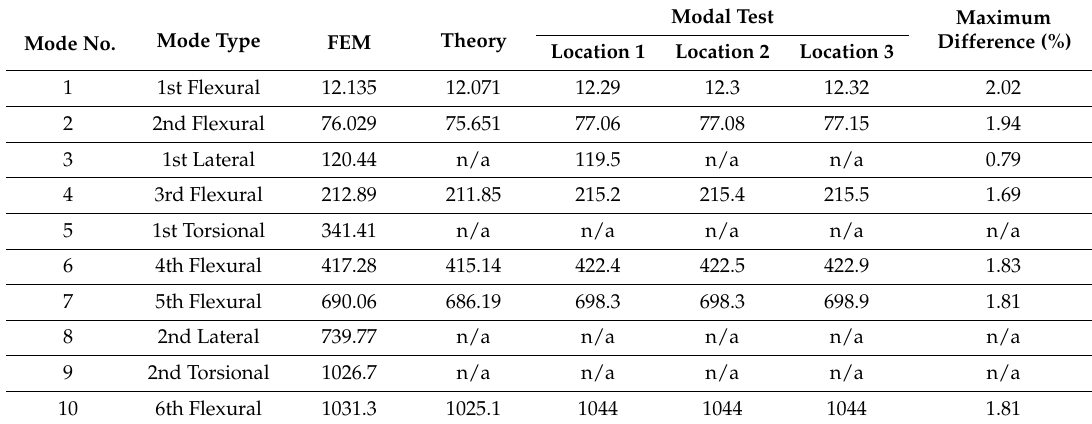
Table 2. Natural frequencies of the cantilever beam (Hz).